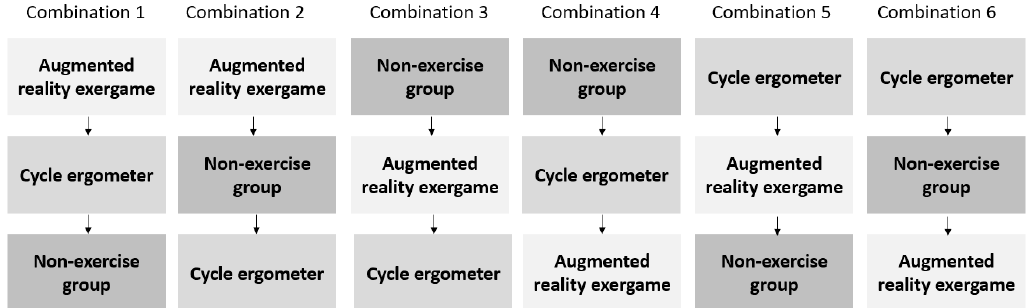
Figure 1. Different combinations of exercise implementation.